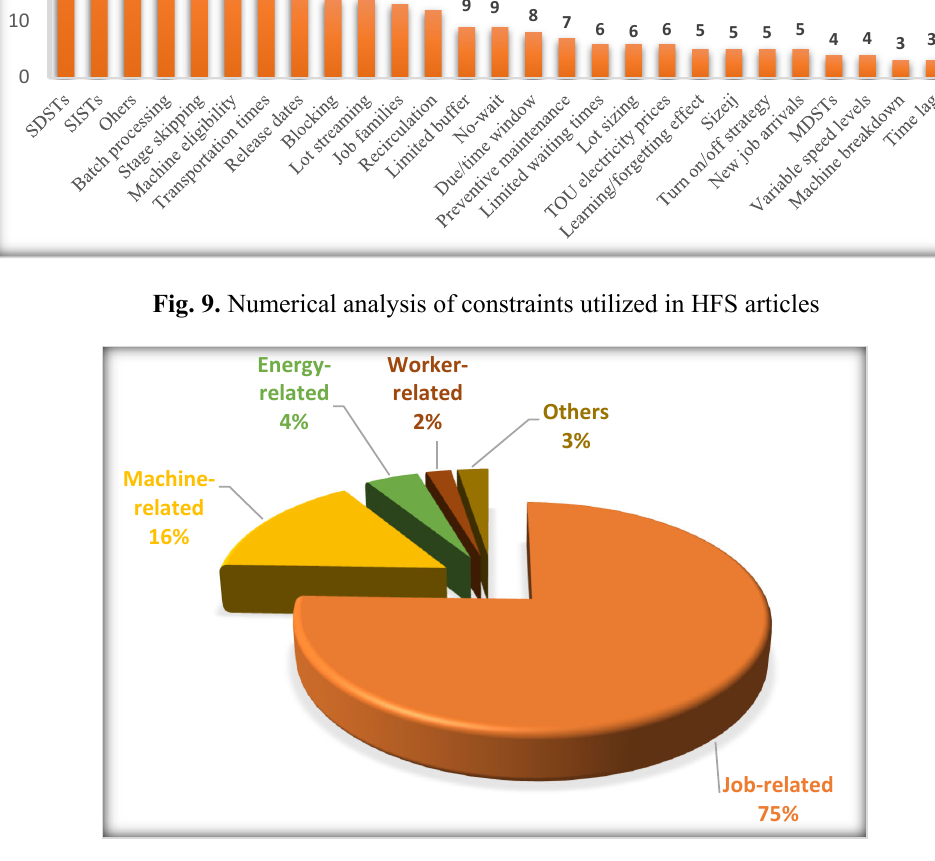
Fig. 10. A classification for constraints of